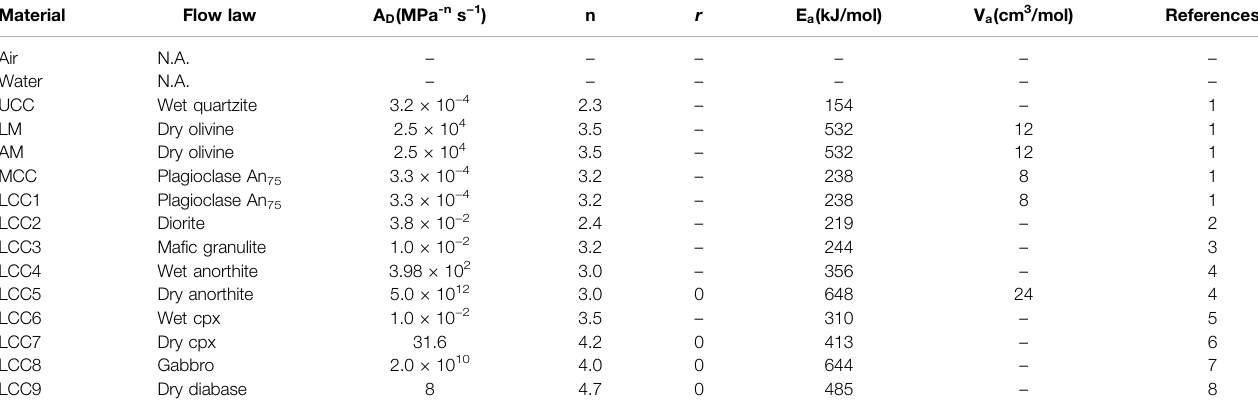
TABLE 1 | Rheological parameters of material used in this study a .